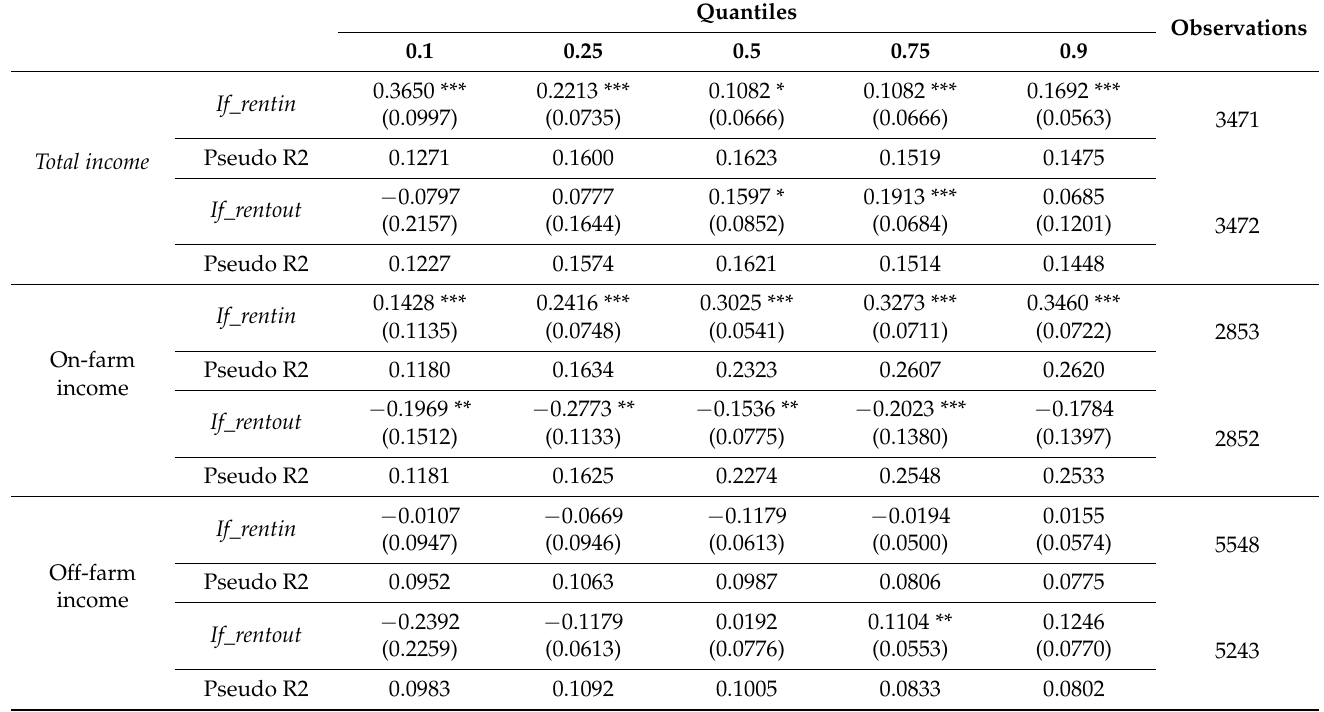
Table 5. Differential effects of farmland rental participation on rural household